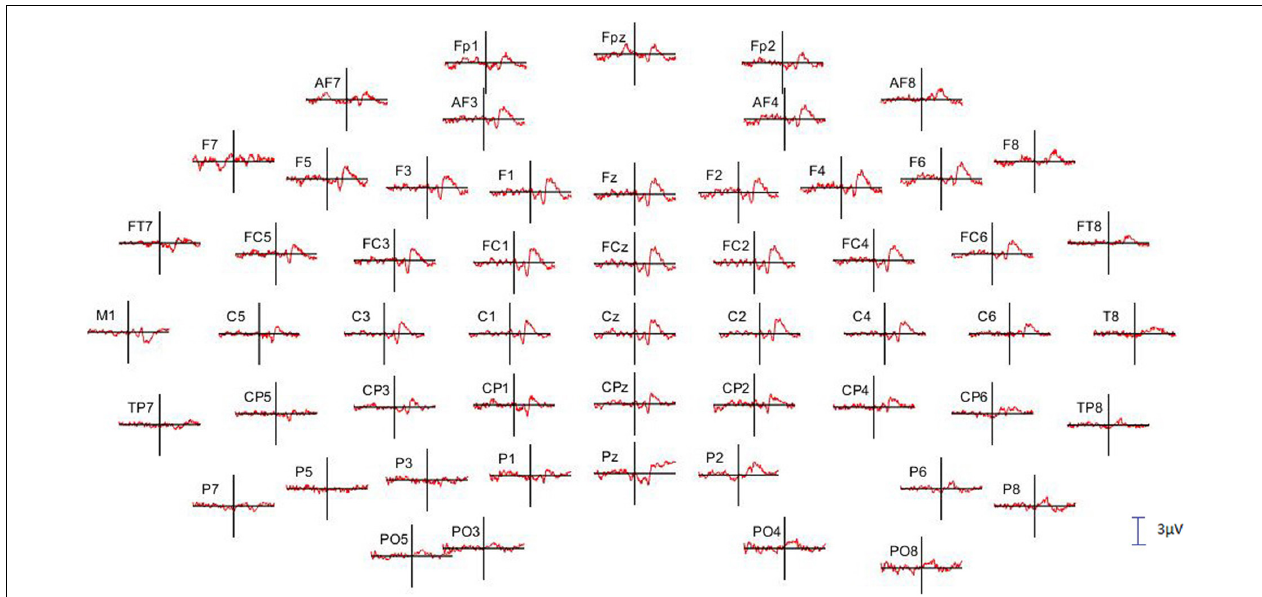
FIGURE 3 | Full scalp array of grand average event-related potential (ERP; n = 6 subjects) showing the fronto-central distribution of the N331-P476 components triggered by the onset of the PWL. The vertical lines indicate the onset of the PWL. Only 55 of the 64 electrodes are illustrated, and the missing ones present too many artifacts. The calibration bar corresponds to 3 µ V, positivity